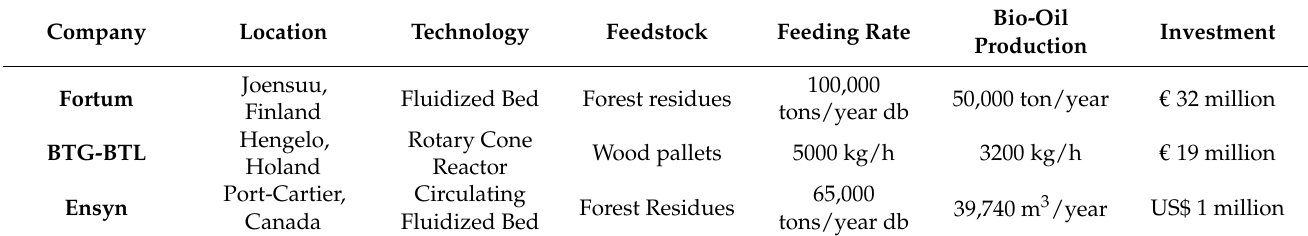
Circulating Fluidized